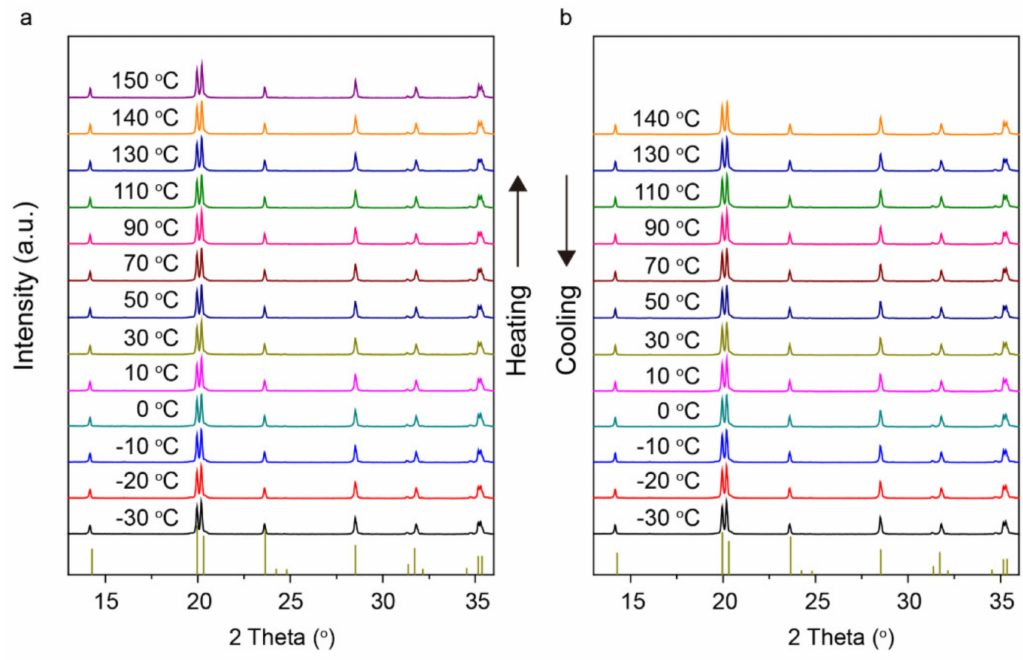
Figure 2. XRD patterns for the as-prepared LY0.1ZP electrolyte from − 30 to 150 ◦ C: ( a ) during the heating and ( b ) the cooling